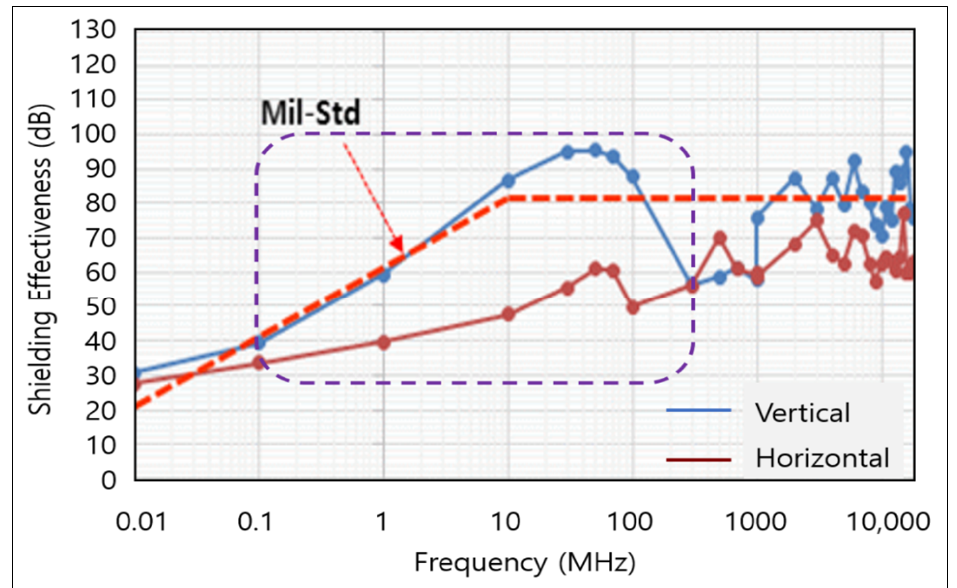
Figure 4. Shielding effectiveness of specimen #1(W = 0).